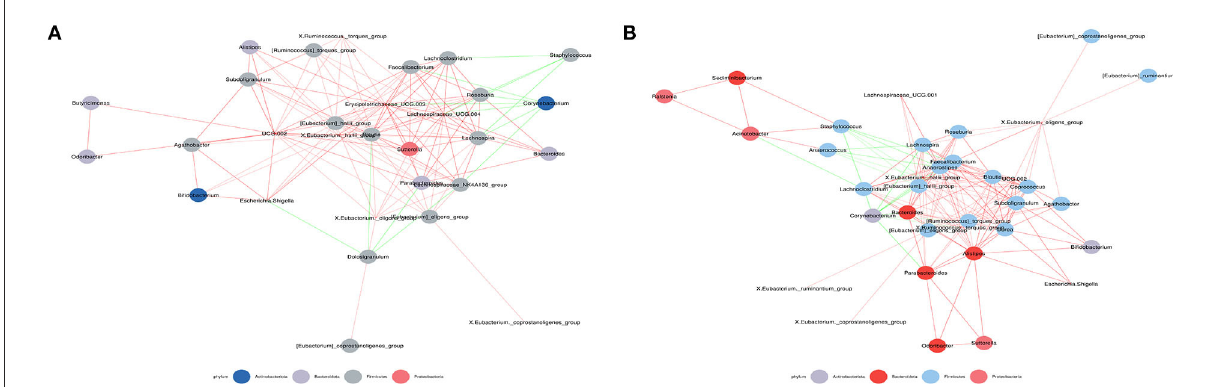
FIGURE5 Co-occurrence network map. (A) Correlation analysis of intestinal and nasal microbiota at low-exposure group. (B) Correlation analysis of intestinal and nasal microbiota at high-exposure group. Species with Spearman Coef > 0.8 and p < 0.01 are shown by default in the figure. The size of nodes indicates the abundance of species, and different colors indicate different species. The color of the line indicates a positive and negative correlation, red indicates positive correlation, and green indicates negative correlation. The thickness of the line indicates the Pearson correlation coefficient, the thicker the line is, the more correlative species are. The more lines, the more connected one species is to